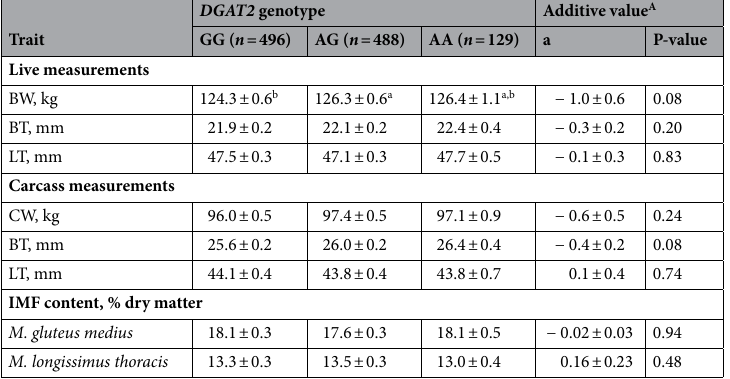
Table 4. Least square means and additive values (± standard error) for body weight (BW), carcass weight (CW), backfat (BT) and loin (LT) thickness and intramuscular fat (IMF) content by DGAT2 genotype. A Additive allele substitution of G for A. a,b Within trait, means with different superscripts differ significantly (P <